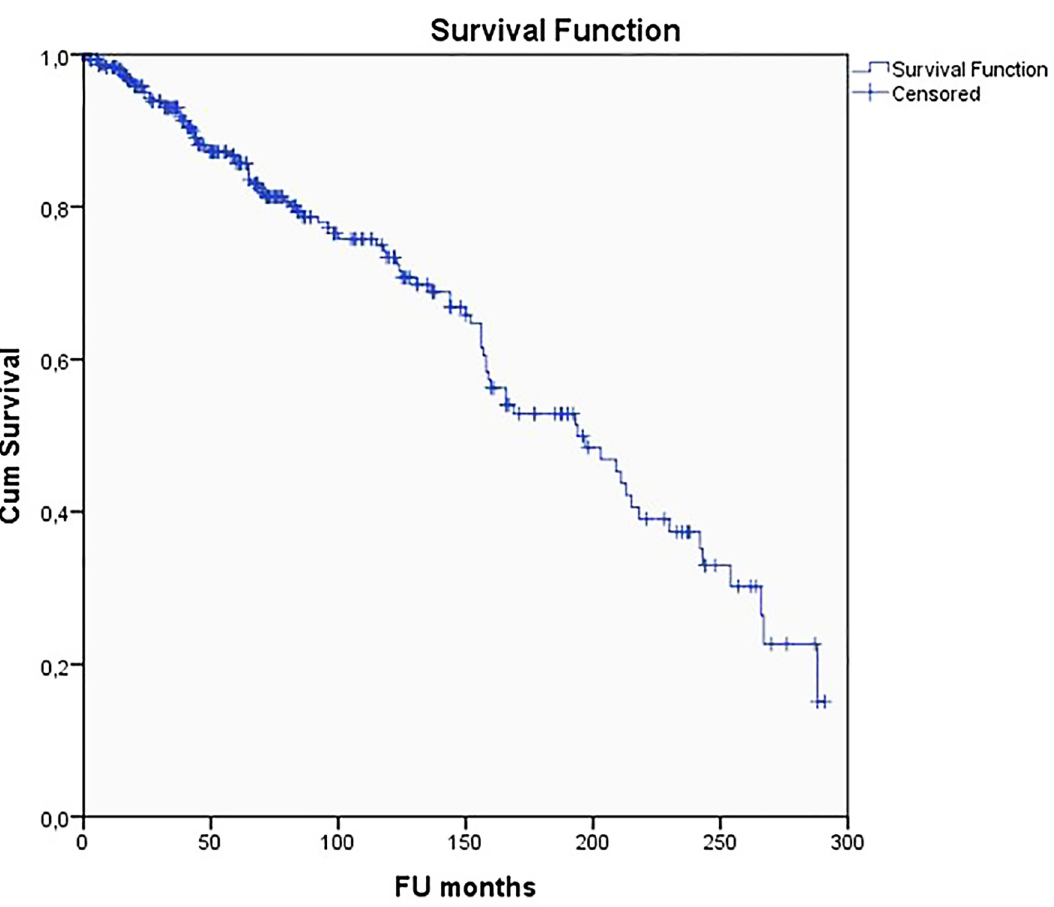
Fig 2. Kaplan-Meier cumulative survivorship of all MAT: endpoint removal of the allograft by total meniscectomy or during conversion to a knee arthroplasty (TKA or UKA).